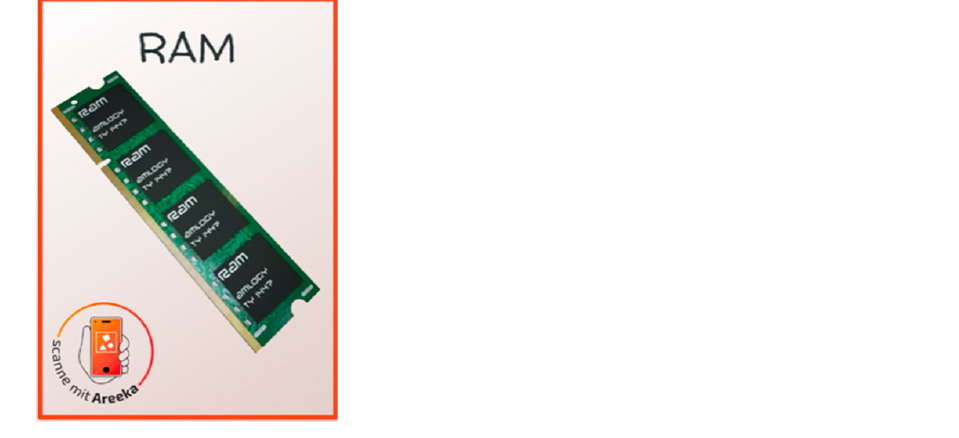
Figure 3. Example of a PCBuildAR card with a 2D image as a trigger; here, a RAM component is shown.